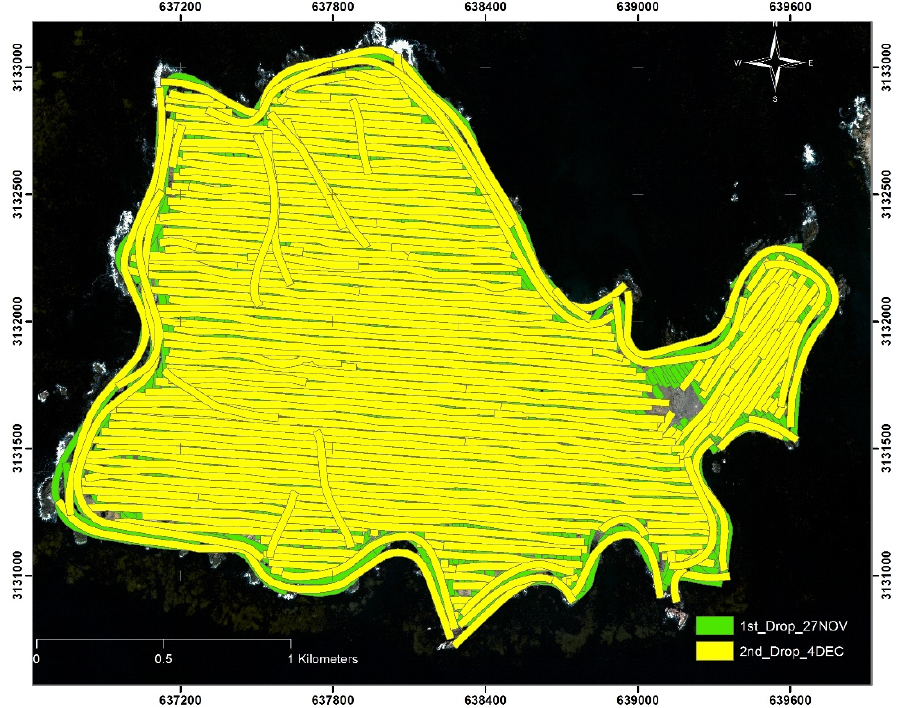
Figure 4. Map showing the helicopter coverage during the first (green; 27 November 2013) and second (yellow; 4 December 2013) bait drops during the mouse eradication on San Benito Oeste island. The gap shown to the east is where the fishing camp is located, which was treated by hand and bait stations after each bait drop.